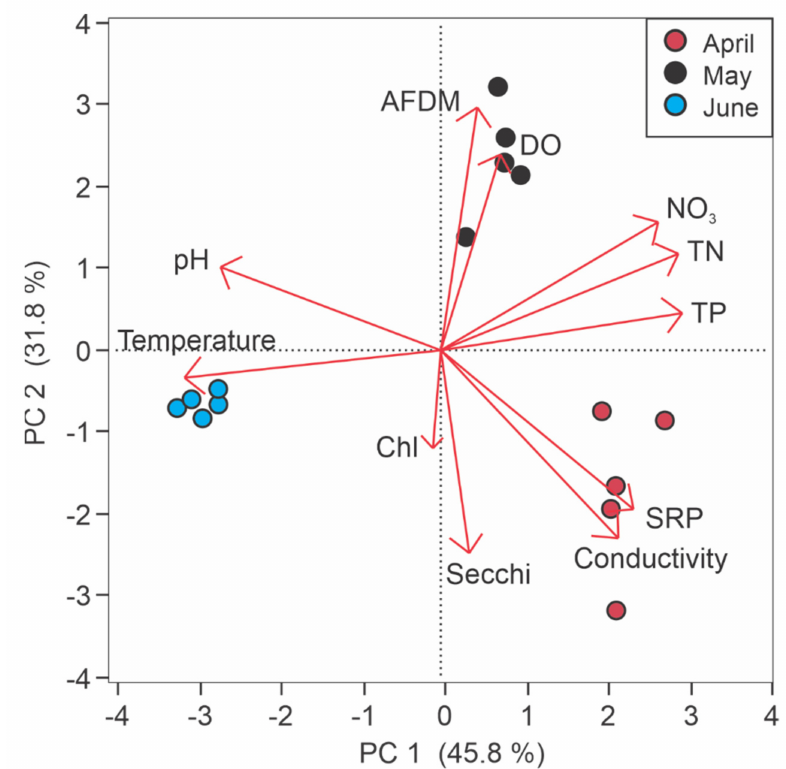
Figure 2. Water quality differences among sampling months (April, May, June) in Roundaway Lake, MS. Circles represent sites and colors represent months, with closer sites being more similar in water quality. Arrows denote the variable loadings and strengths (arrow length) relative to each principal component. The principal component analysis shows water quality segregated more by month than by location in the lake, and differences are driven mainly by temperature, nutrients, water clarity, dissolved oxygen (DO), and suspended organic matter (ash-free dry mass,